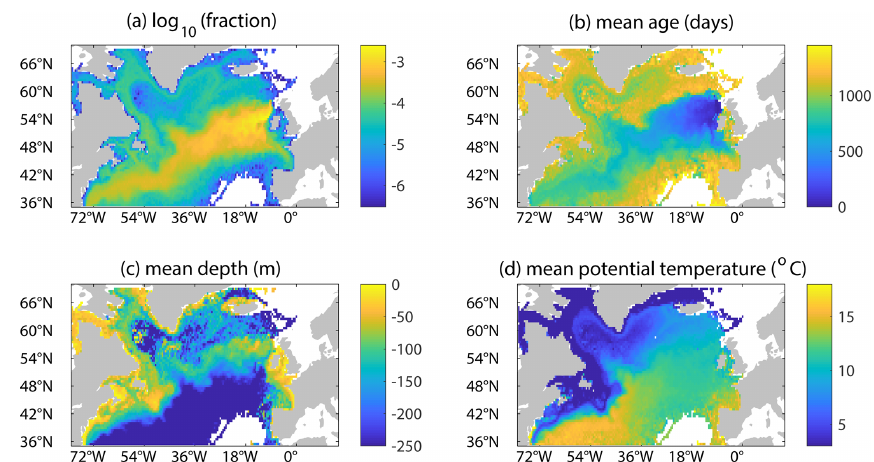
Figure 9. Ensemble mean particle statistics for the 1992–88 ARIANE hindcast: (a) log 10 fraction of total particles; (b) mean age in days; (c) mean depth in metres; (d) mean potential temperature in ◦ C.